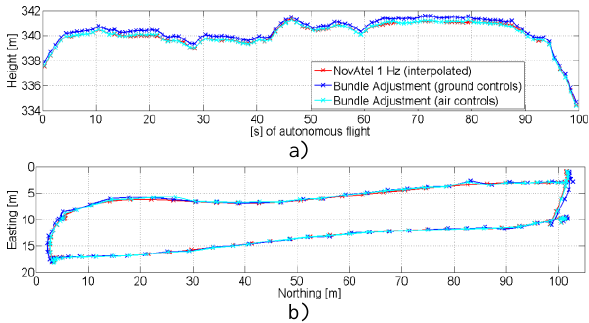
Figure 5. Positions computed from AT; a) heights, and b) horizontal